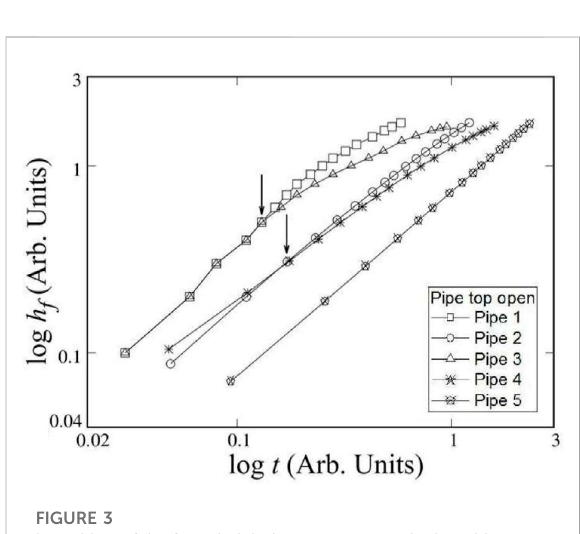
FIGURE 3 Logarithm of the foam height in meters versus the logarithm of time in seconds for the same data of Figure 2. The left and right vertical arrows mark the times when the power-law dependence of foam height on time changes in Pipes 1, 2, and 3, 4,